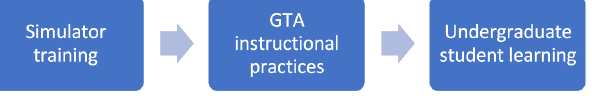
FIG. 1. Simulator training can impact GTAs ’ instructional practices, which can in turn impact undergraduate student